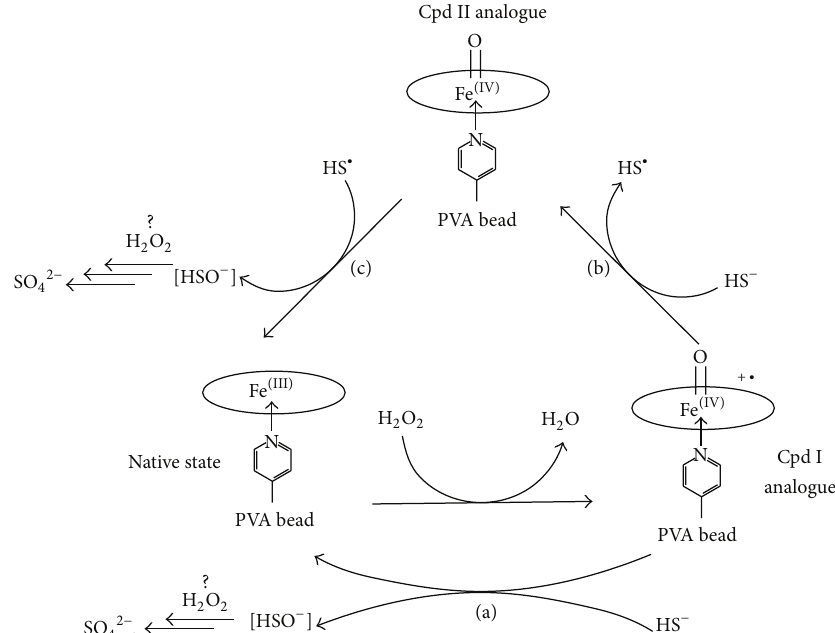
Figure 5: Proposed catalytic path for the immobilized metalloporphin. Path (a) represents the direct oxygen transfer from compound I analogue to sulfide. Paths (b) and (c) represent the rebound mechanism via compound